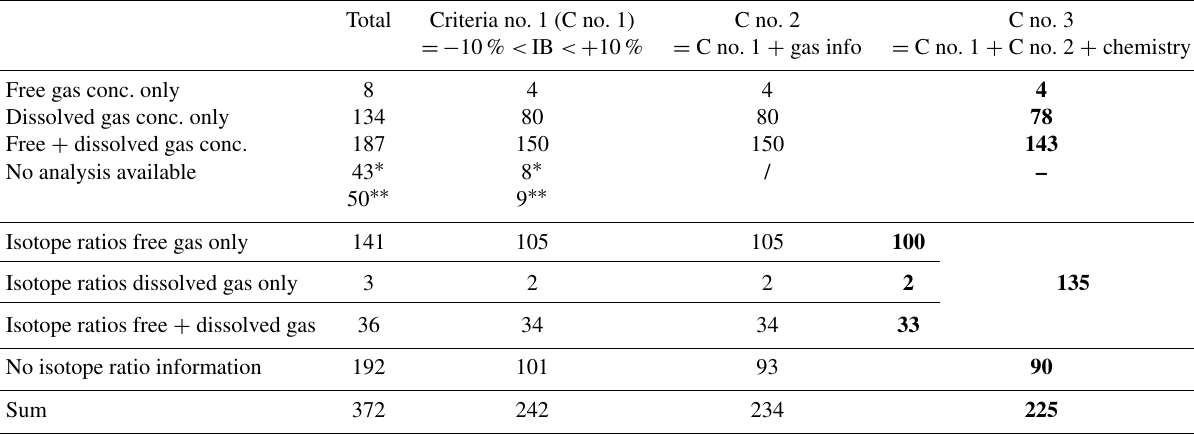
∗ for gas analyses. ∗∗ for chemistry analyses. Values in boldface indicate retained subsets for